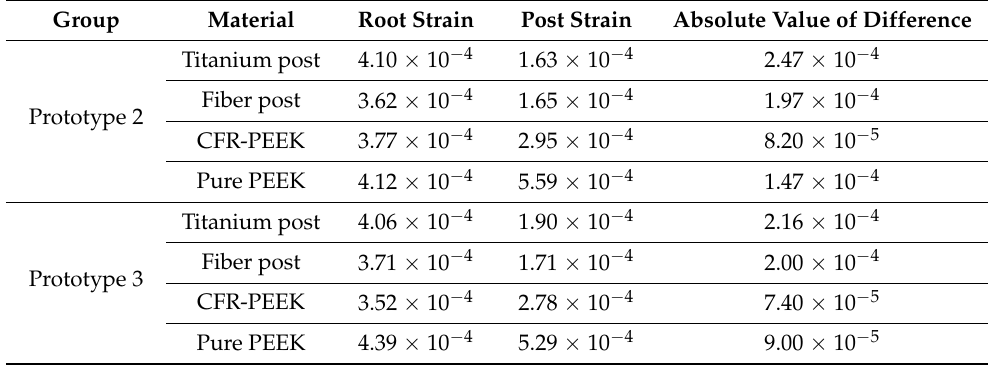
Table 2. Strain of root and post.